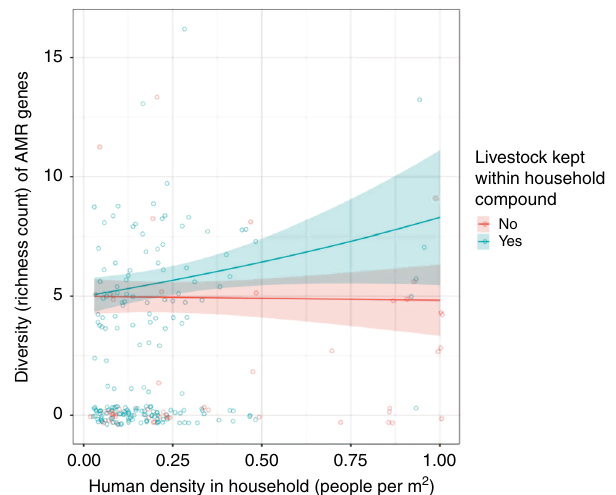
Human density in household (people per m 2 ) Fig. 2 Antimicrobial resistance (AMR) gene diversity and human density. Fit of the zero-in fl ated hurdle model, modelling how diversity of AMR genes in seed-eating birds increased with human density, when livestock were part of the vertebrate host community at household interfaces. Coloured lines represent the presence or absence of livestock in households, and shading on either side of each line represents 95% con fi dence intervals. A subset ( n = 152) of E. coli isolates were included in this